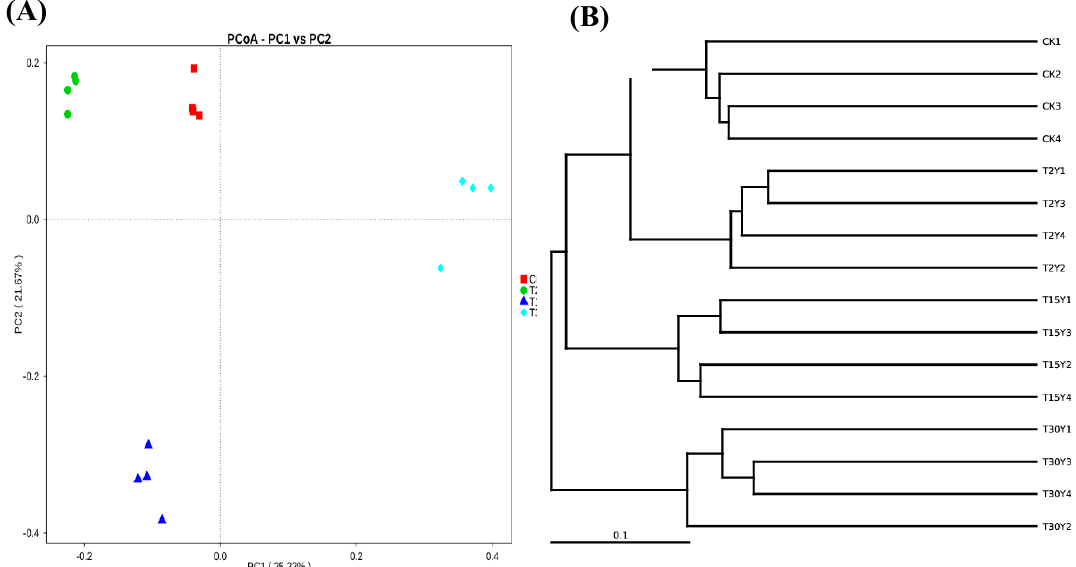
Figure 3. ( A ) Unweighted UniFrac (UUF) principal coordinate analysis (PCoA) and ( B ) unweighted pair group method with arithmetic mean analysis (UPGMA) of fungal communities in control and di ff erent age monoculture tea fields. CK, T2Y, T15Y, and T30Y represent fields consecutively planted for 0, 2, 15, and 30 years, respectively.